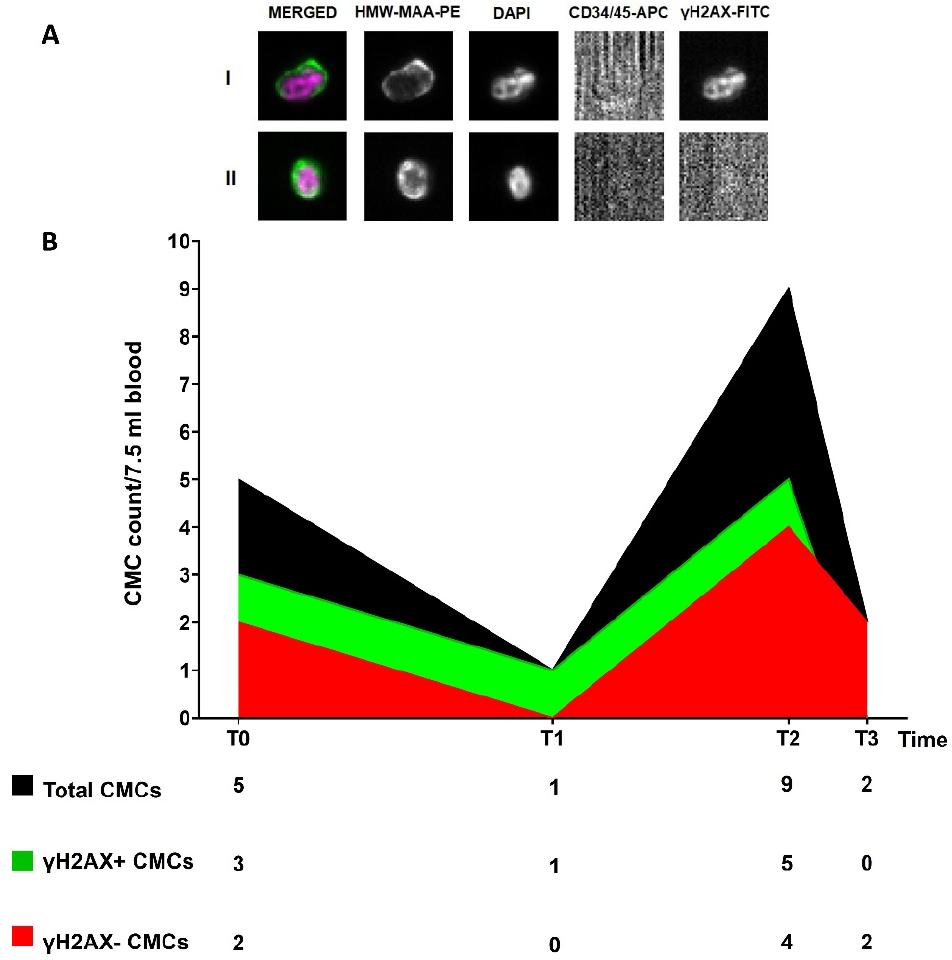
Figure 3. ( A ) Representative images of γ H2AX-positive (I) and γ H2AX-negative (II) CMCs enriched and detected through the CellSearch ® system (10 × magnification). Fluorophore-conjugated antibodies were used: anti-High Molecular Weight Melanoma Associated Antigen (HMW-MAA-PE), anti-CD34/45-APC for endothelial cells and leukocytes, respectively, and anti- γ H2AX-FITC for DNA-damaged cells. DAPI was used to stain nuclei. No staining is observed in the APC channel in the presence of a CMC; ( B ) Longitudinal plot of CMC count. The table below displays the number of total CMCs and of γ H2AX-positive and –negative CMCs at each time point.